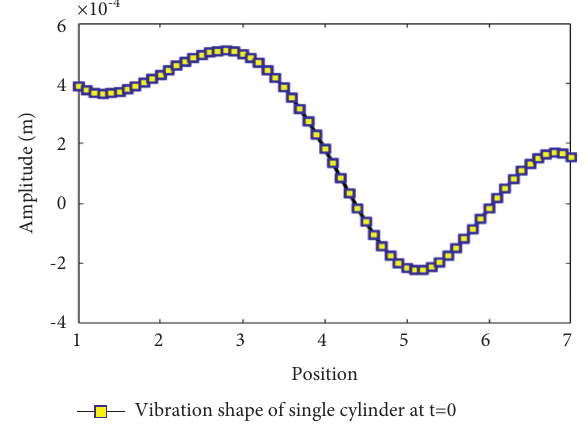
Figure 14: Vibration shape of cylinder I at t � 0.